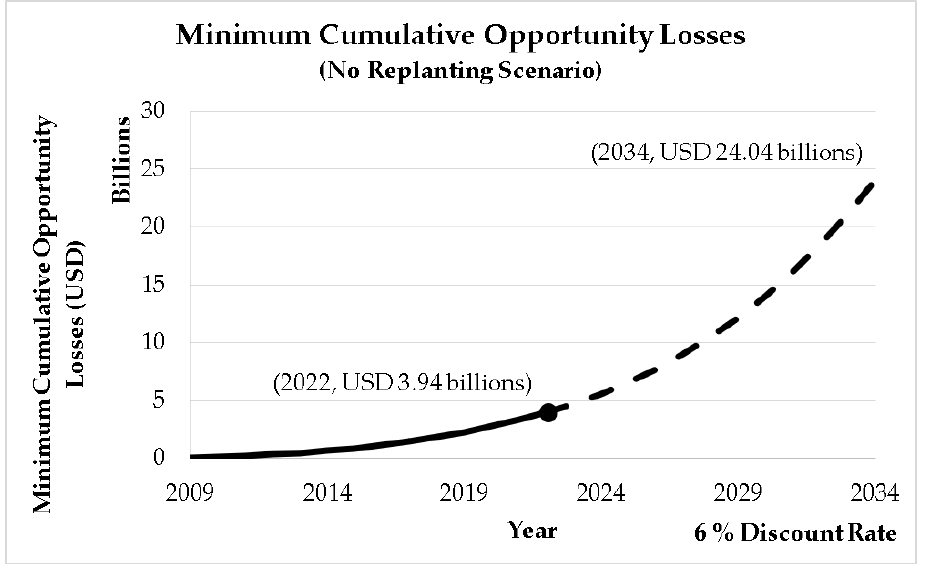
Figure 8. Minimum cumulative opportunity losses due to ageing of oil palm crops (no replanting